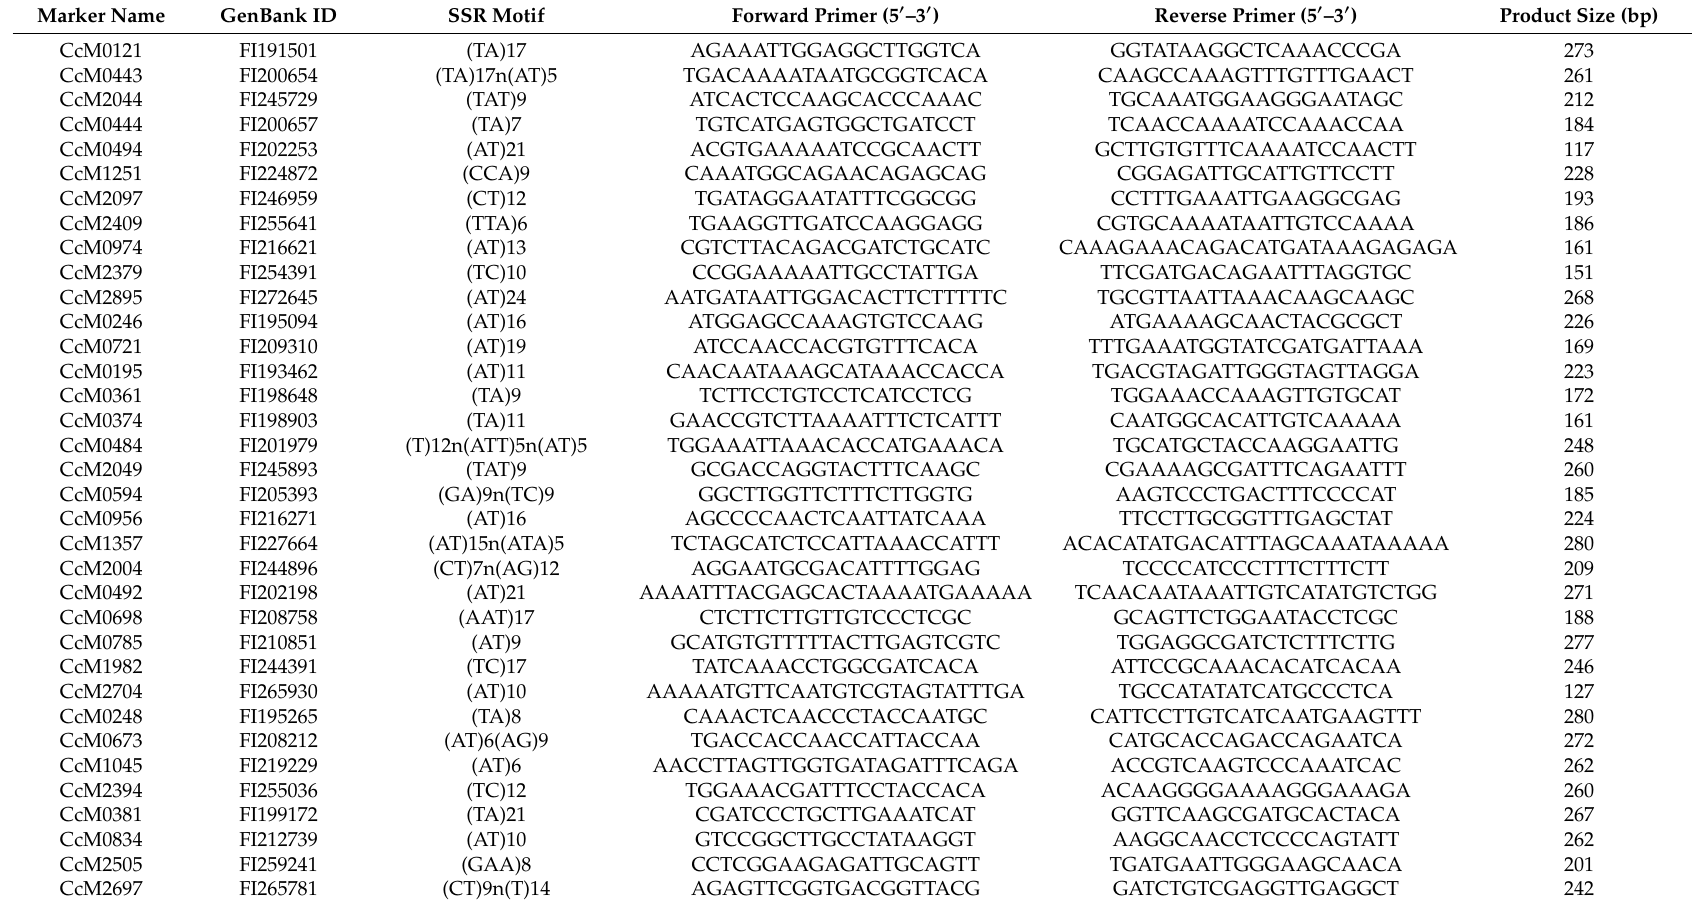
Table 2. Primer sequences of the 35 simple sequence repeat (SSR) markers used in this